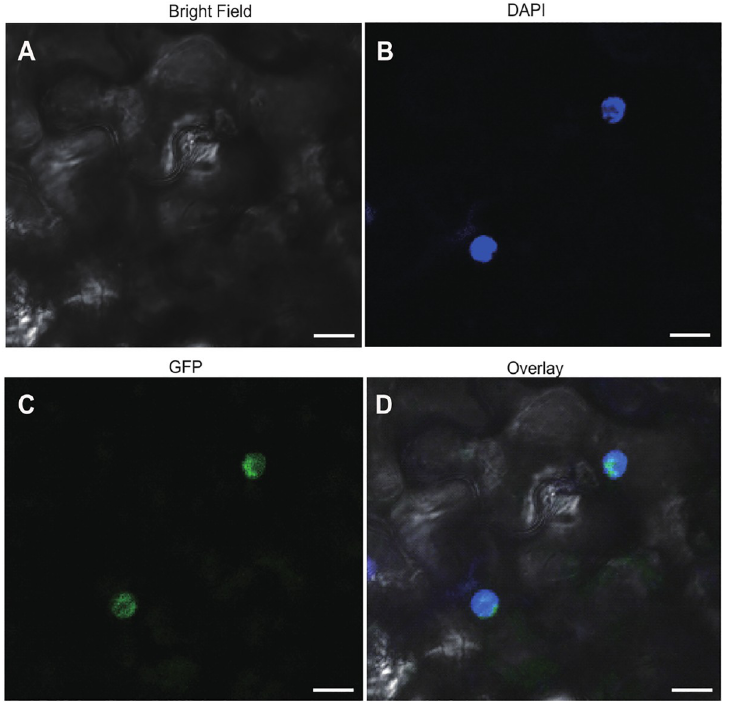
Fig 6. Subcellular localisation of TRM5 translational reporter protein in Nicotiana benthamiana leaves. TRM5 was fused to Green Fluorescent Protein (GFP) to yield a TRM5-GFP translational fusion recombinant protein. The construct was transiently expressed in N . benthamiana leaves and subcellular localisation was determined by confocal laser-scanning microscopy. ( A ) Bright field, ( B ) DAPI stained, ( C ) GFP fluorescence, ( D ) overlay of DAPI and GFP imagines. Scale bars = 20 μ